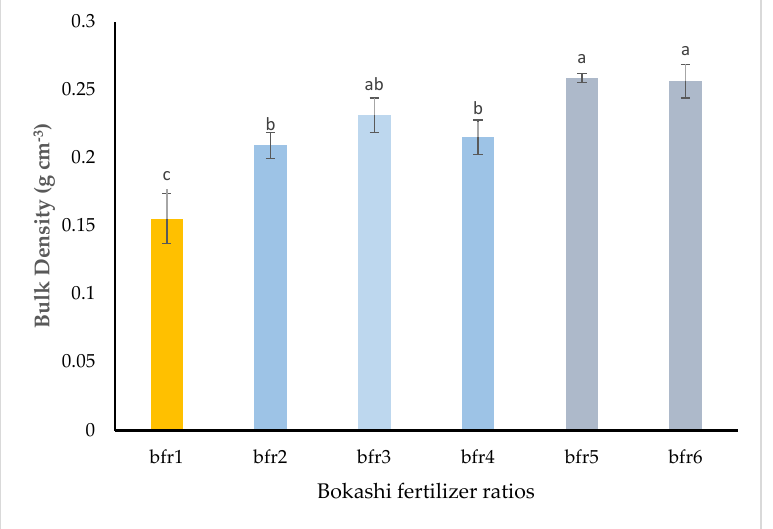
Figure 3. Effects of different bokashi fertilizer ratios on the bulk density. Bfr1 is the bokashi fertilizer ratio comprising of 80% HBW:0% CD:20% PHC. Bfr2 is the bokashi fertilizer ratio comprising of 80% HBW:10% CD:10% PHC. Bfr3 is the bokashi fertilizer ratio comprising 70% HBW:20%CD:10% PHC. Bfr4 is the bokashi fertilizer ratio comprising 70% HBW:10% CD:20% PHC. Bfr5 was the bokashi fertilizer ratio comprising 60% HBW:20% CD:20% PHC. Bfr6 was the bokashi fertilizer ratio comprising 60% HBW:25% CD:15%